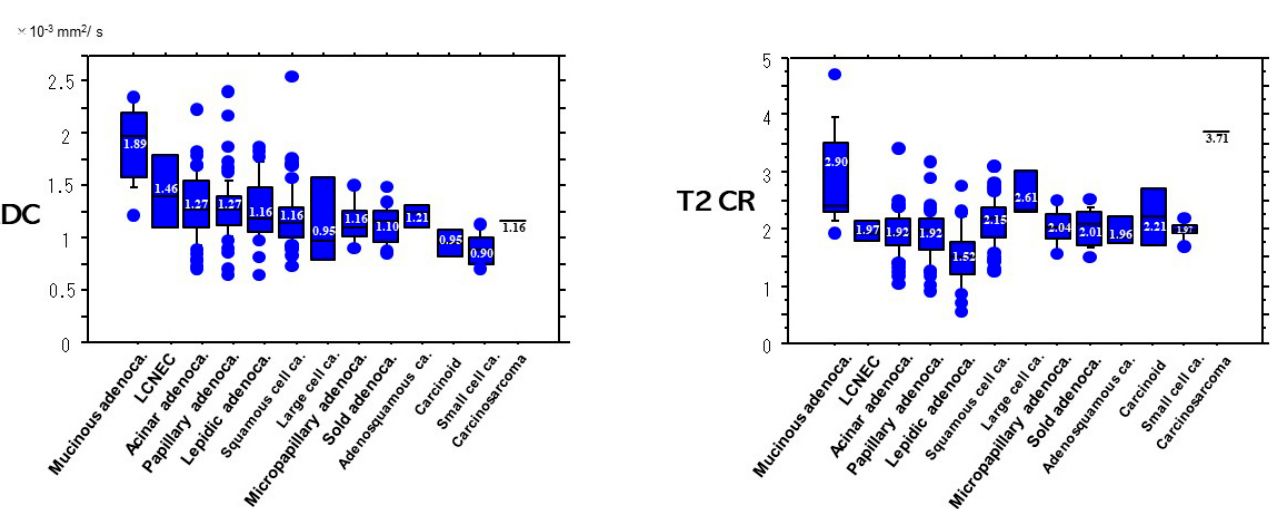
Table 2. Diagnostic efficacy by DWI and T2WI.